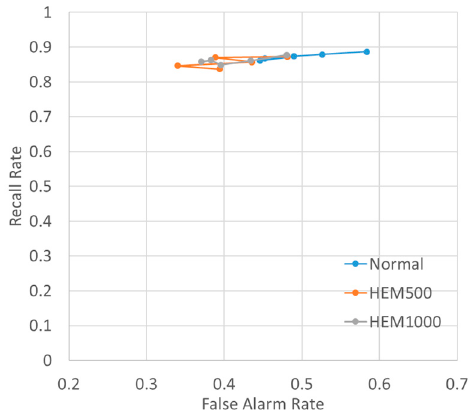
Figure 12. FAR versus RR. Our method greatly reduced the FAR while keeping nearly the same RR.